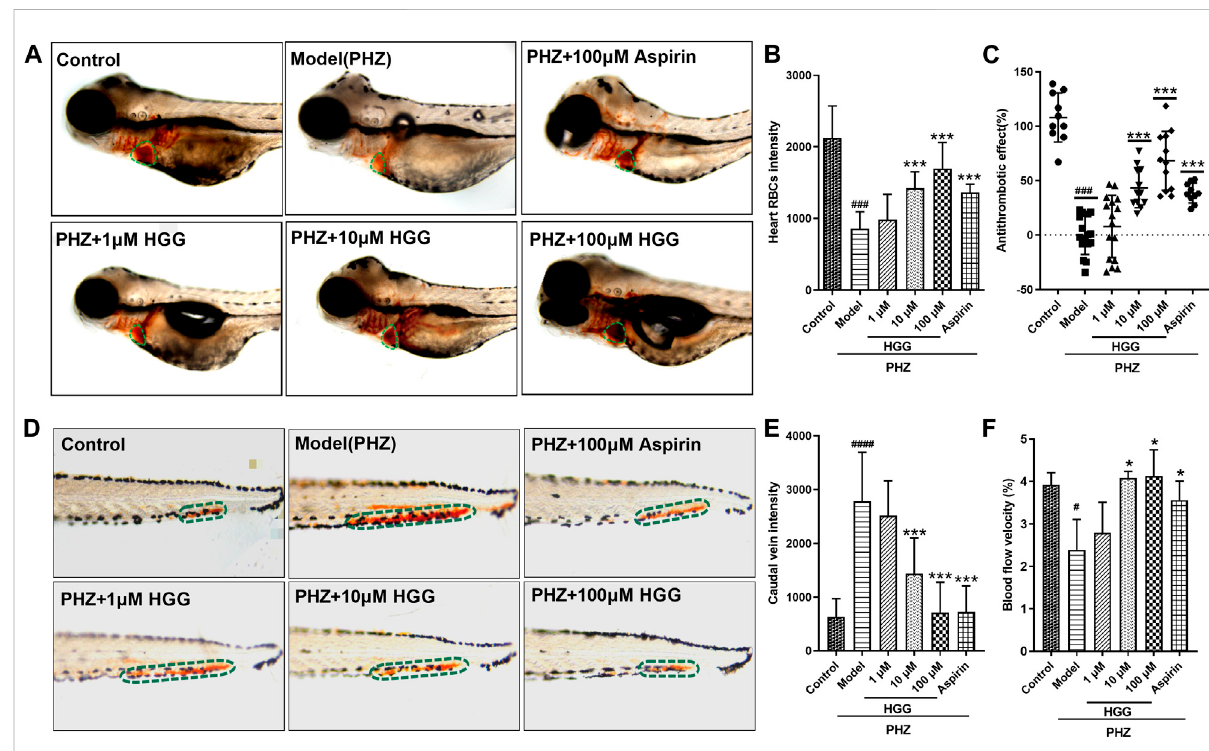
FIGURE 8 Thrombus formation and hemodynamicchanges in PHZ-stimulatedzebra fi sh with different concentrations ofHGG, and anti-thromboticdrug aspirin. (A) Representative images of the heart RBC (green dotted line) stained with O-dianisidine after HGG, or aspirin treatment; (B) Quantitative analysis ofheart RBCs intensity; (C) The anti-thrombotic effect based on heartRBC intensity; (D) Erythrocytesaggregation in thecaudal vein (circled with green dotted line); (E) Quantitative analysis of the caudal vein intensity for thrombotic zebra fi sh; (F) Determination of blood fl ow in the caudal vein after treated with PHZ, and co-treated with HGG. ### p < 0.001 vs. Control, *** p < 0.001 vs.